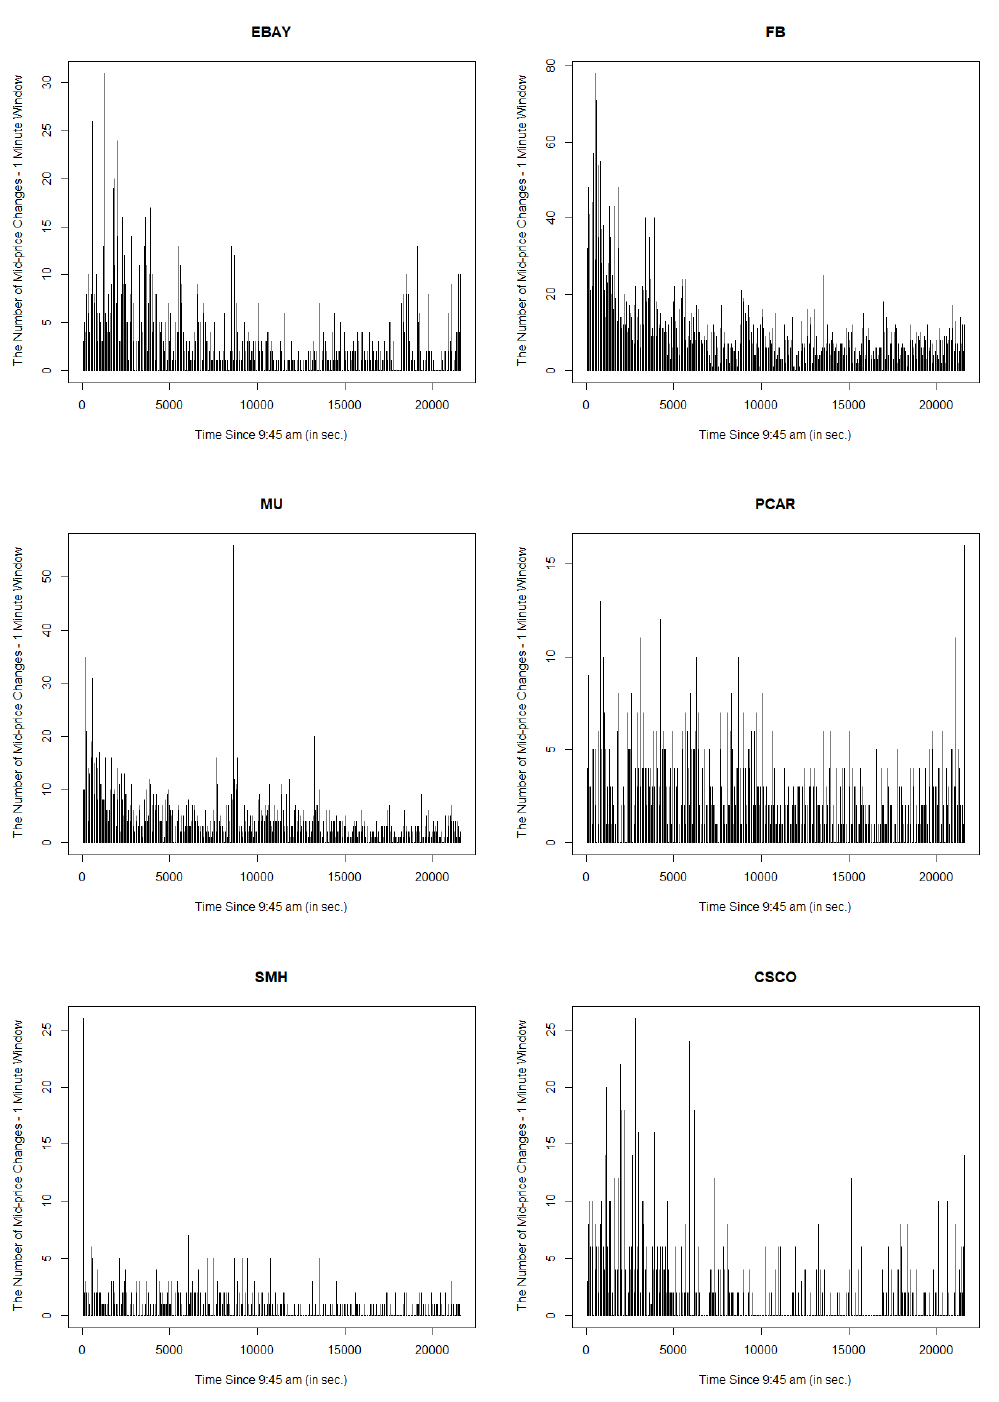
Figure 4. Clustering features for 6 different